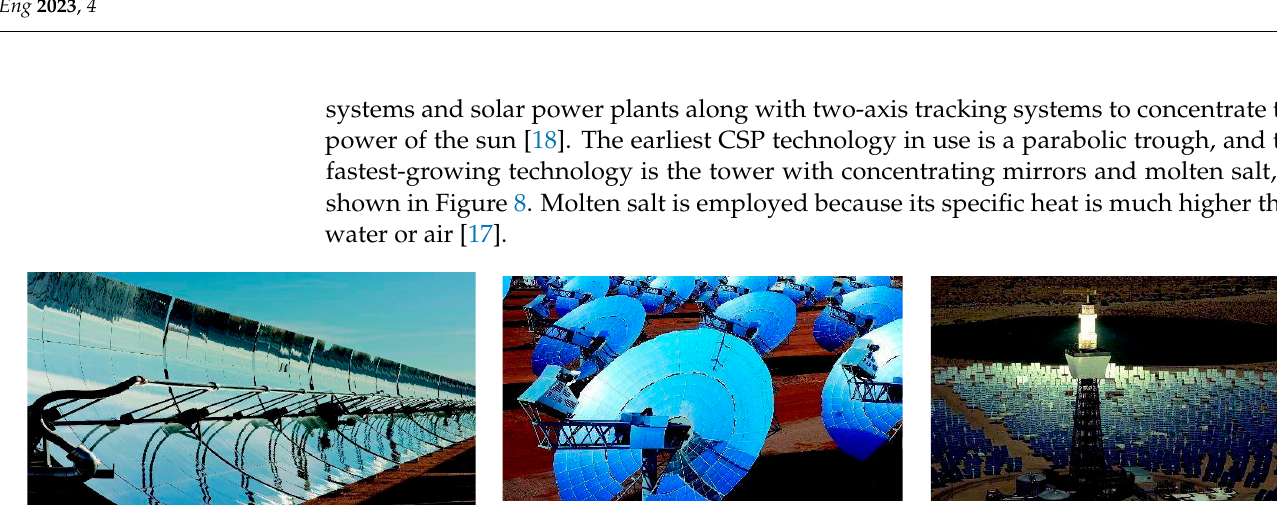
Figure 8. Various solar thermal energy collectors with concentrating mirrors [17,18].